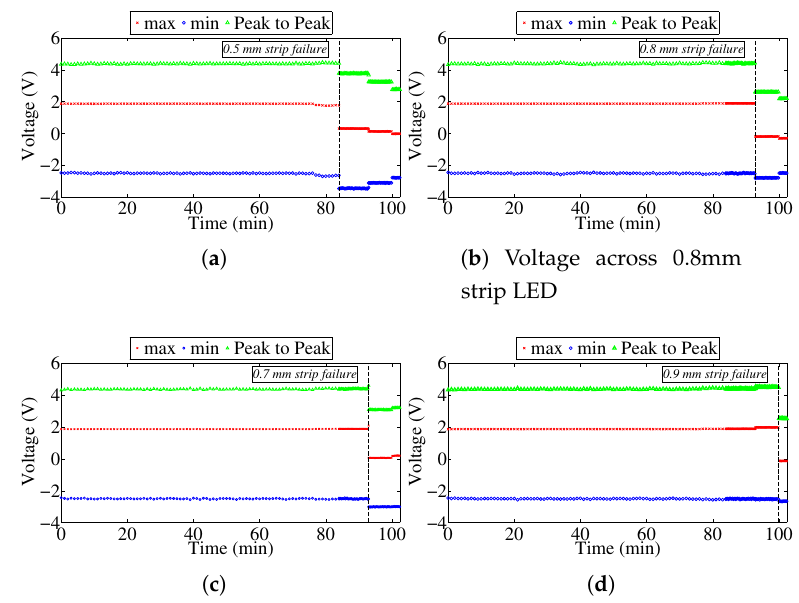
Figure 11. Maximum, minimum and peak-to-peak voltages across different strip LEDs. ( a ) voltage across 0.5 mm strip LED; ( b ) voltage across 0.8 mm strip LED; ( c ) voltage across 0.7 mm strip LED; ( d ) voltage across 0.9 mm strip LED.